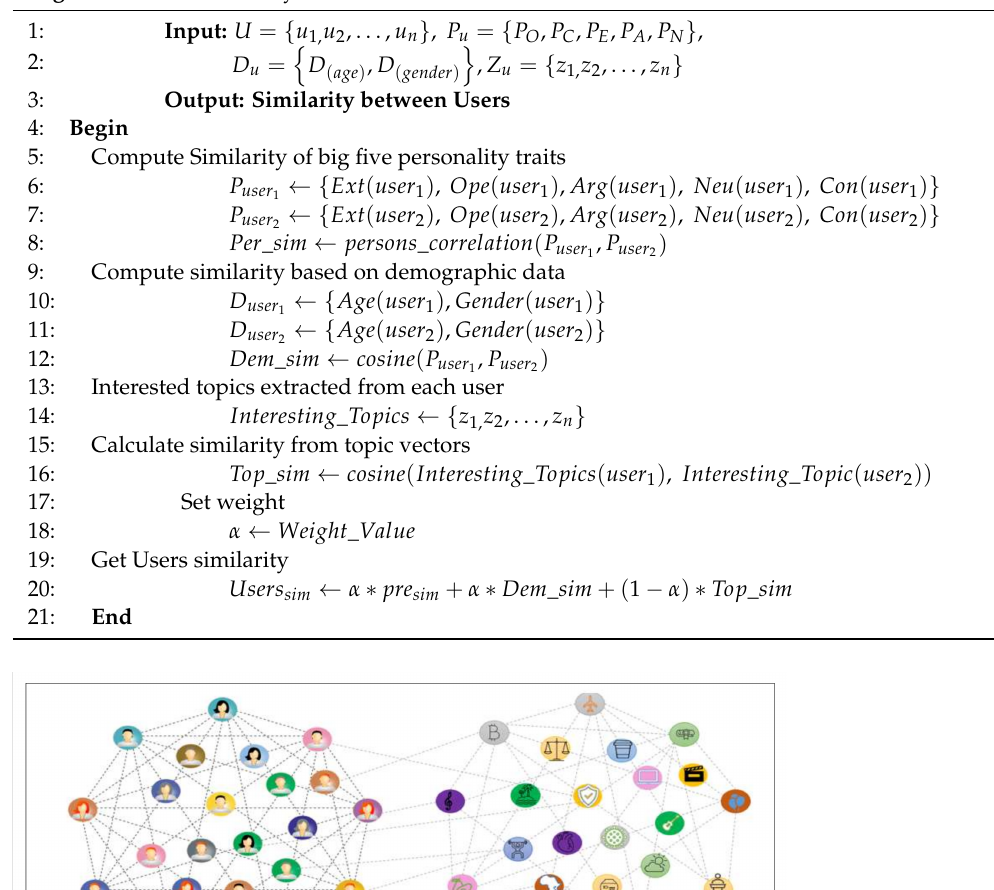
Algorithm 1 Get Similarity between Users